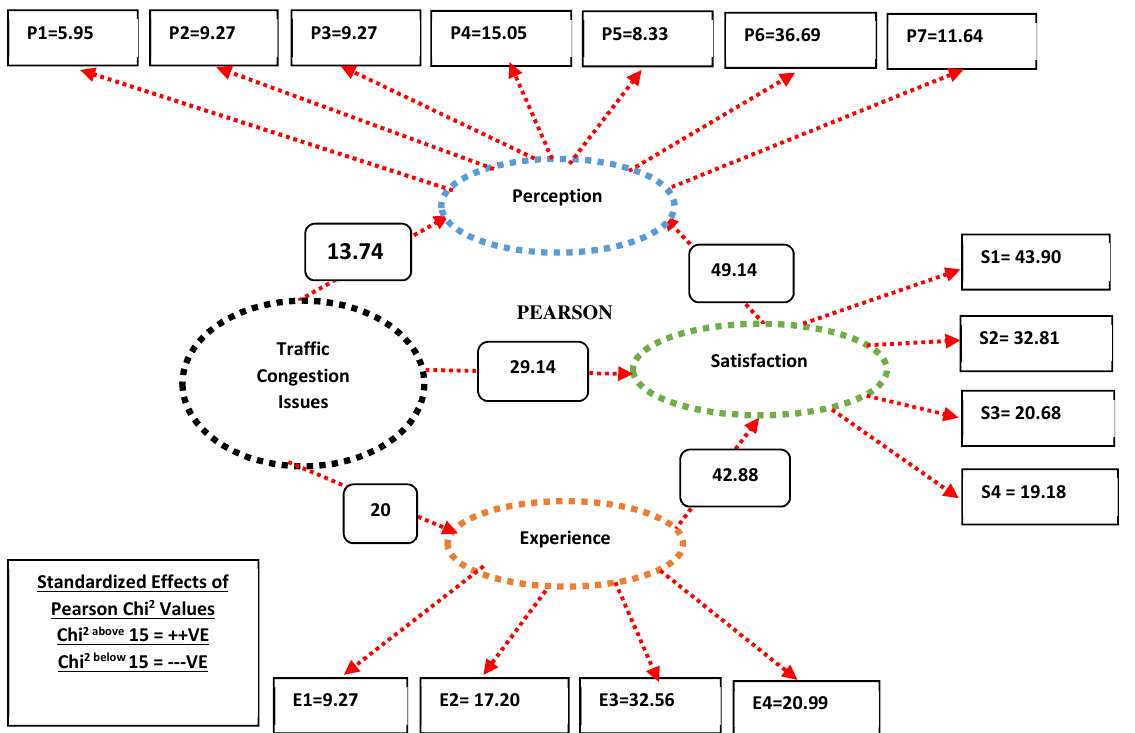
FIG. 5: ESTIMATED RESULTS OF THE MODEL BASED ON PEARSON CHI SQUARE VALUES WITH STANDARDIZED